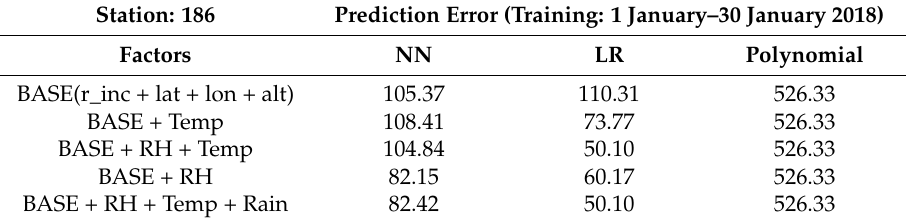
Table 8. Task 3: prediction error of the sensor attribute r_inc coming from monitoring station 186 using neural network, and linear and polynomial regression machine learning models on the IoT Sensors dataset.